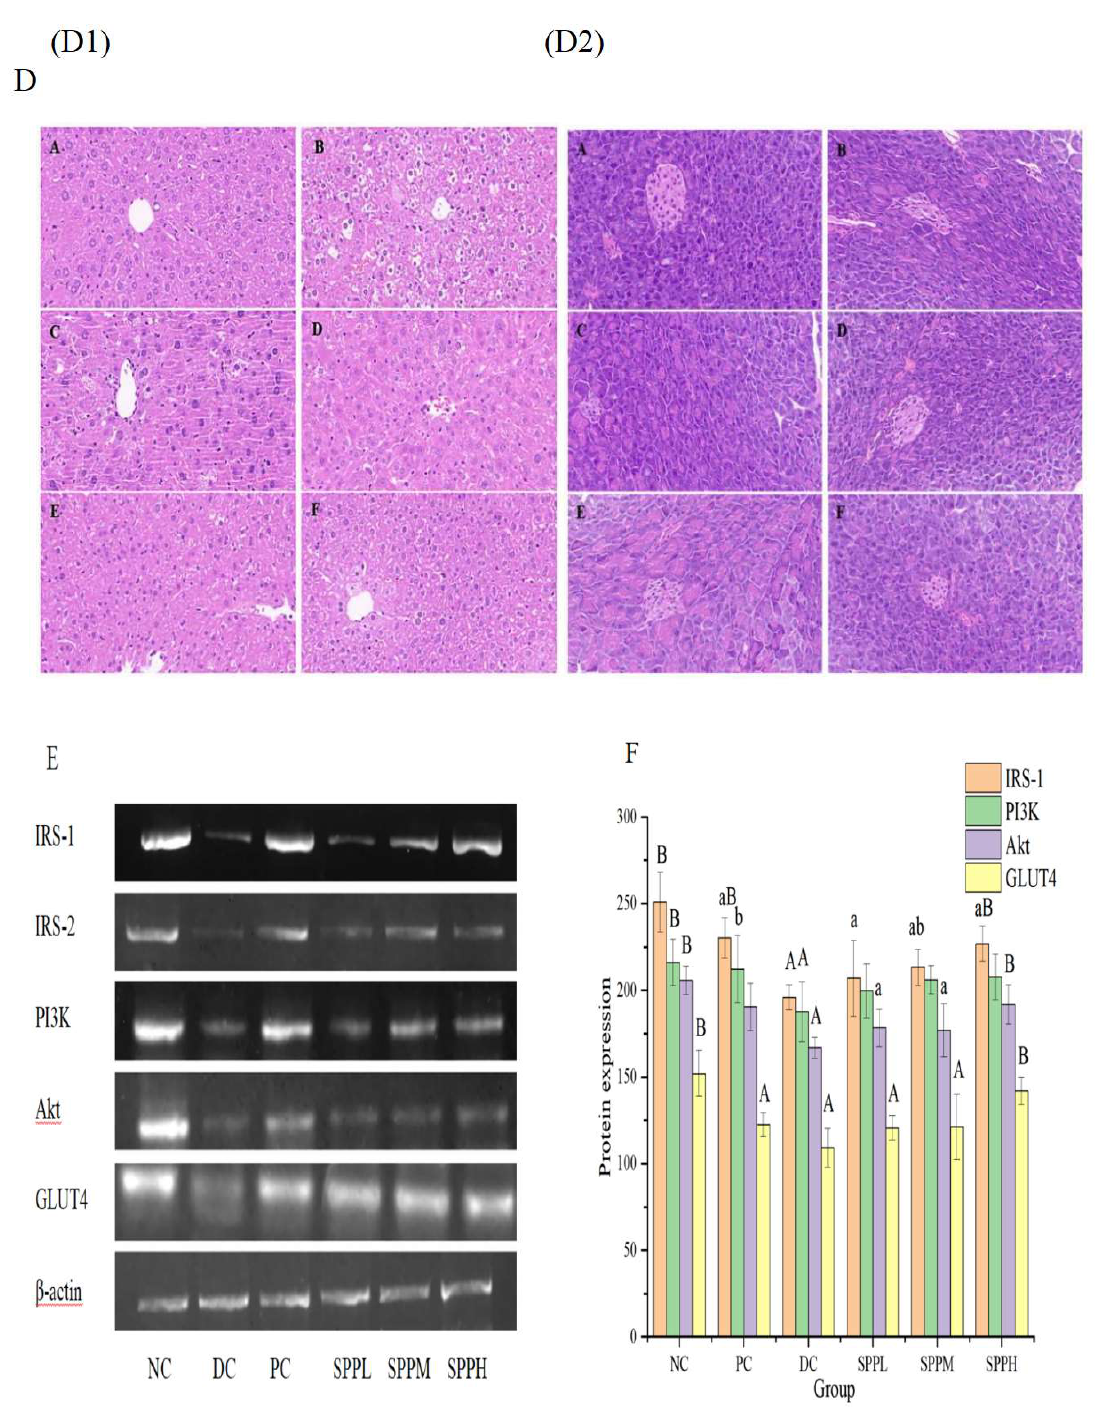
Figure 3. In vitro hypoglycemic activity analysis. ( A ) Effects of SPP on body weight and blood glucose of type 2 diabetic mice. ( B ) Effect of SPP on organ index of type 2 diabetic mice ( C ) Serm lipid levels in each group of mice. ( D ) Histocyte staining in mice. ( D1 ) Hematoxylin-eosin staining of liver tissue, ( D2 ) Hematoxylin-eosin staining of pancreatic tissue. A: NC group; B: DC group; C: PC group; D: SPPL group; E: SPPM group; F: SPPH group. ( E ) Effects of SPP on the expressions of IRS-1, IRS-2, PI3K, Akt, and GLUT4 genes in diabetes mice. ( F ) Protein expressions of IRS-1, PI3K, Akt, and GLUT4. Note: a ( p < 0.05) and A ( p < 0.01) represent the ratio of normal group, while b ( p < 0.05) and B ( p < 0.01) represent the ratio of negative control group ( A – C , F ).